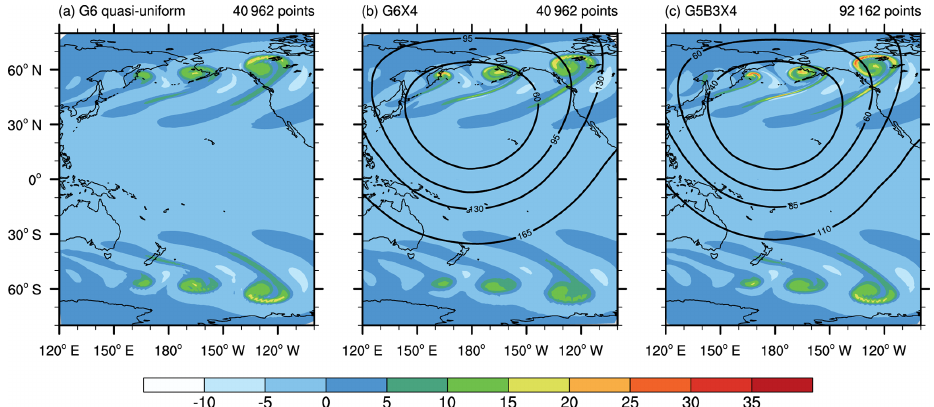
Figure 6. Adding a symmetrical perturbation in the Southern Hemisphere in the baroclinic wave test. The relative vorticity (10 − 5 s − 1 ) field at the model level nearest to 850hPa on day 10 is shown for (a) quasi-uniform G6, (b) variable-resolution G6X4, and (c) G5B3X4 meshes. Only the nonhydrostatic core is used. The values in the Southern Hemisphere are substituted by their opposite values. The raw vorticity values on the triangular cell have been remapped to the Voronoi cell. The contour lines denote the smoothed mesh cell sizes (km). Table 2. Mesh resolution, time steps, and diffusion coefficients for the simple-physics